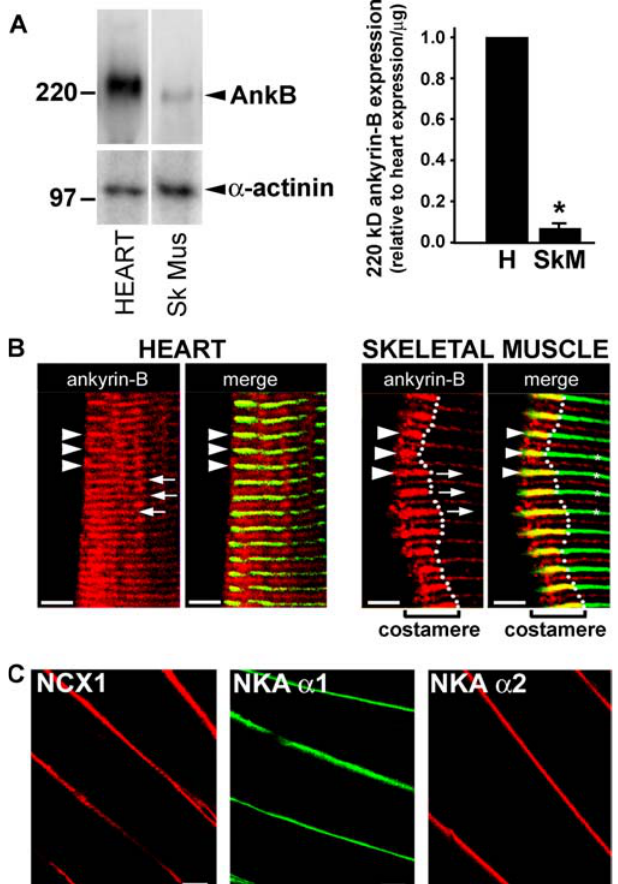
Figure 3. The Ankyrin-B-Based Complex Is a Specialized Feature of Heart (A) Relative expression of 220-kDa ankyrin-B in adult mouse heart and skeletal muscle ( n ¼ 3, p , 0.05). For the immunoblot in the left panel, 50 l g of total lysate was analyzed. (B) Ankyrin-B (AnkB) immunostaining (red) in frozen sections of heart (H) and skeletal muscle (Sk Mus, SkM). The Z-lines (arrowheads, also asterisks in right skeletal muscle panel) overlap with alpha-actinin (green). Arrows indicate A-bands. Ankyrin-B is localized at costameres in skeletal muscle, visualized as staining continuous with alpha-actinin near the sarcolem- ma, but does not extend into the interior. Ankyrin-B localizes over the A- band in both heart and skeletal muscle. Scale bars ¼ 5 l m. (C) NCX1 (left panel), NKA alpha 1 (middle panel), and NKA alpha 2 immunostaining (right panel) in skeletal muscle. Scale bars ¼ 18 l